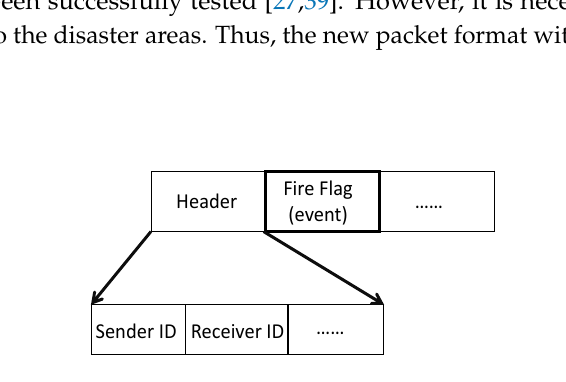
Figure 2. The new data packet format.